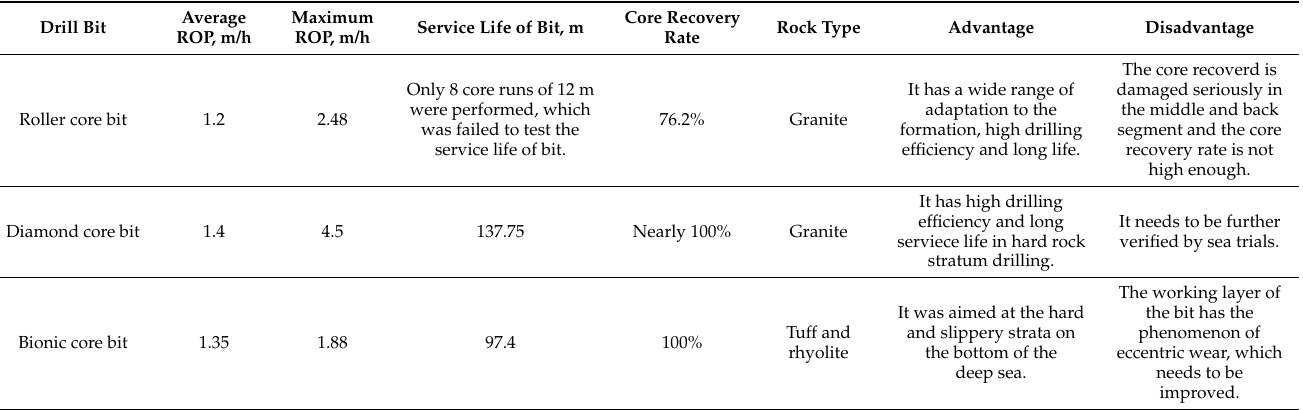
Table 6. Data comparison of three